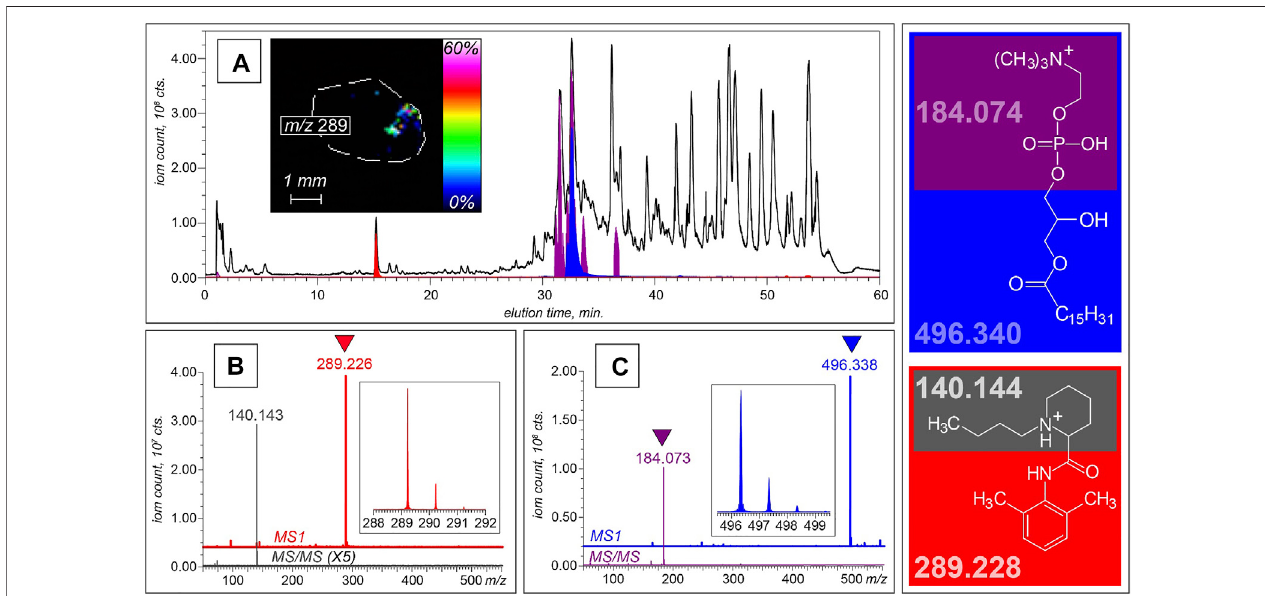
FIGURE 3 | LC-MS and LC-MS/MS analyses of non-volatile components of serum collected from a lung cancer patient. (A) XICs of intact molecular ions at m/z 496.3 (blue) and m/z 289.2 (red), and a fragment ion at m/z 184.1 (purple) plotted on the background of the total ion chromatogram (shown with a black trace). The MS and MS/MS datasets shown at the bottom of this panel were collected at elution time of 15 min (B) and 32 min (C) , allowing these two species to be identi fi ed as bupivacaine and LPC16:0, respectively. The structures of both molecular ions and the most abundant fragments alongside their calculated masses are shown in the right-hand-side diagram. The inset in panel A shows a spatial distribution of the bupivacaine signal within the cross-section of a biopsy tissue obtained with MALDI